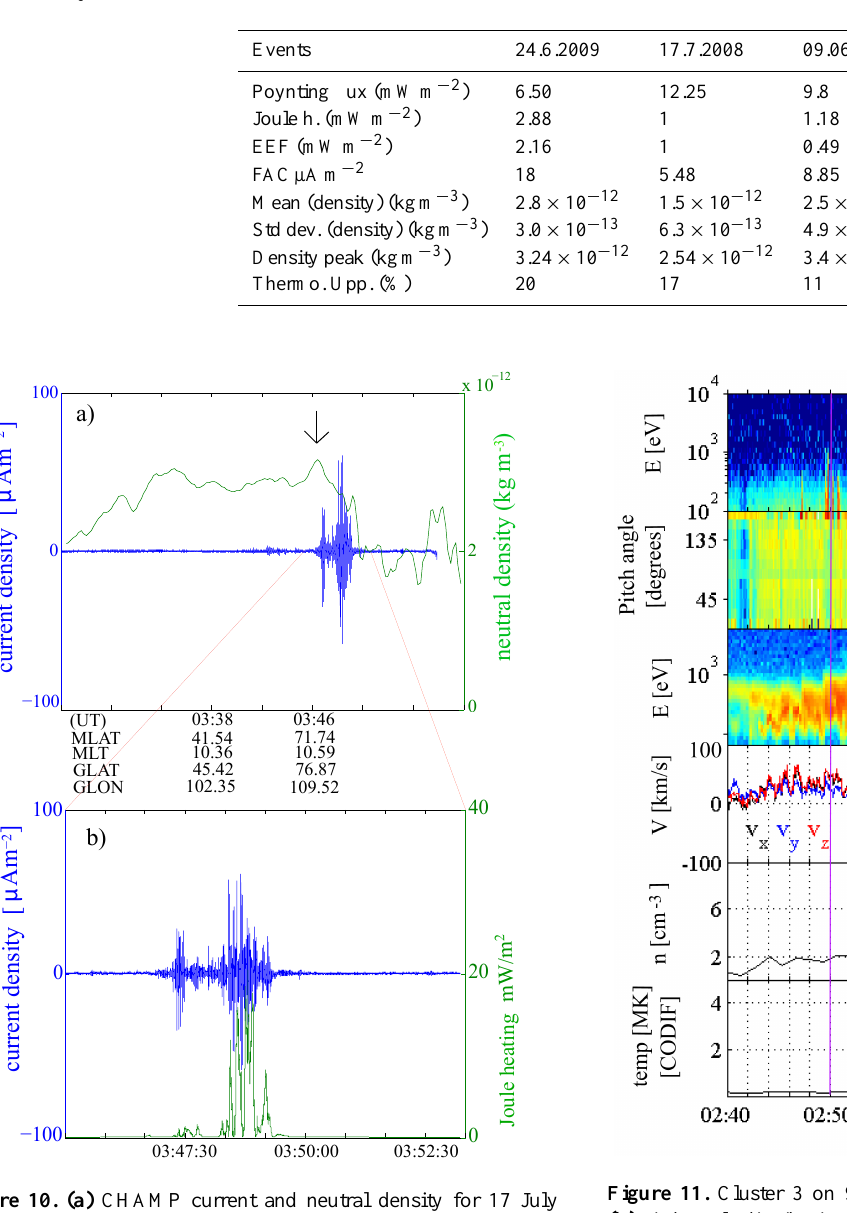
Table 1. Thermospheric upwelling in respect to the neutral background as a function of Poynting flux, Joule heating, EEF and CHAMP current density fluctuations for all three events.